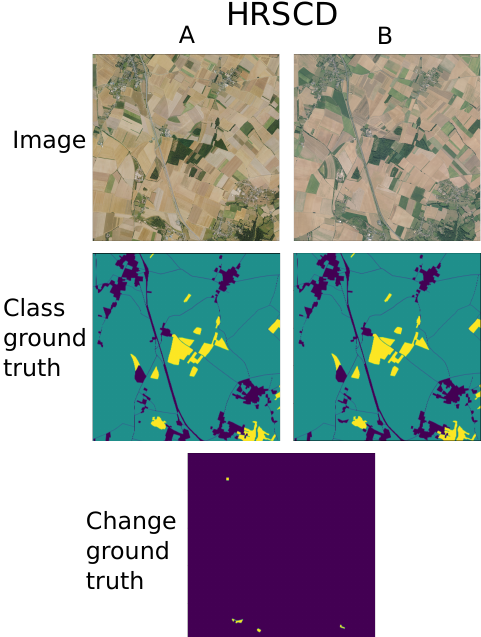
Figure 2. Examples of images, ground truth classes and change ground truth for the semantic change-detection dataset HRSCD